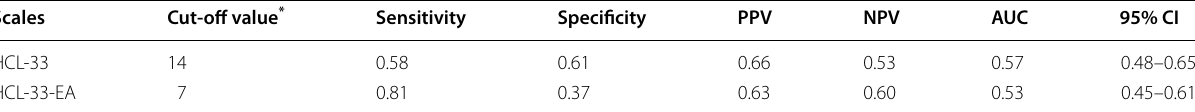
Table 4 Sensitivity, specificity, PPV, NPV, and AUC for the HCL‑33 and HCL‑33‑EA in adolescents with Major Depressive Disorder and Bipolar